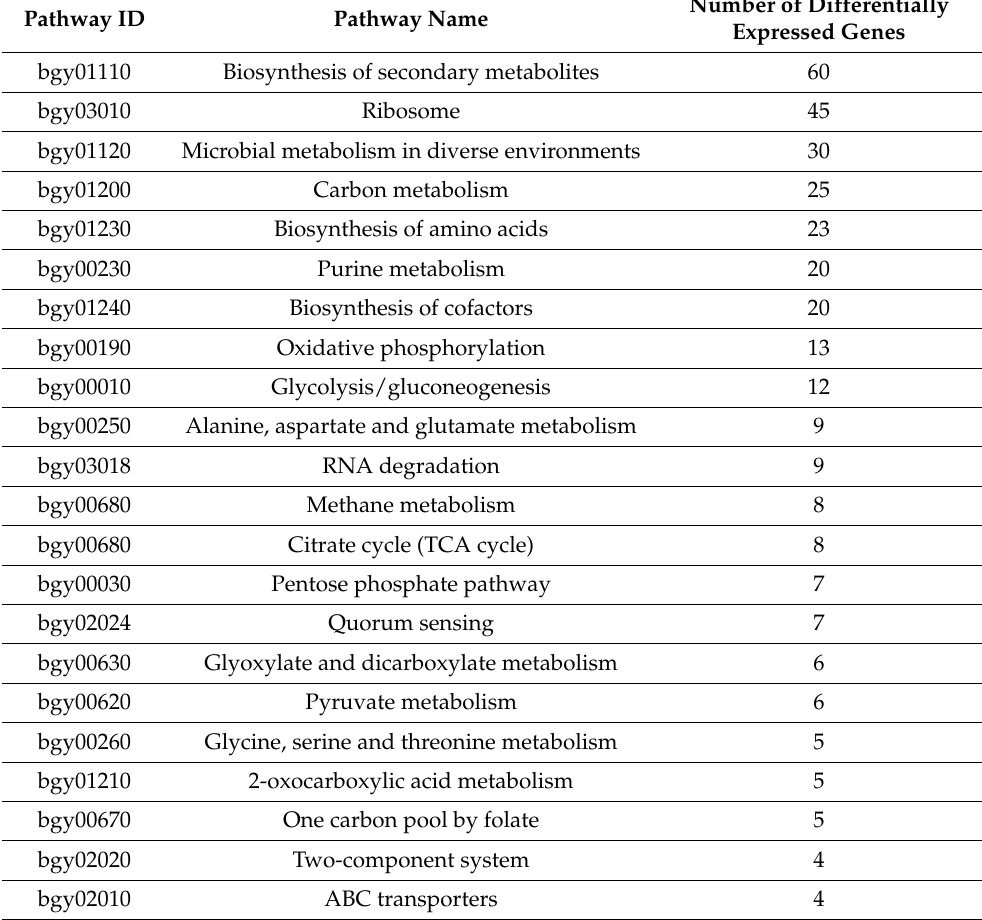
Table 1. Differentially expressed pathways in B. glycinifermentans following exposure to quercetin. A pathway was considered differentially expressed if four or more ≥ two-fold genes were mapped to the